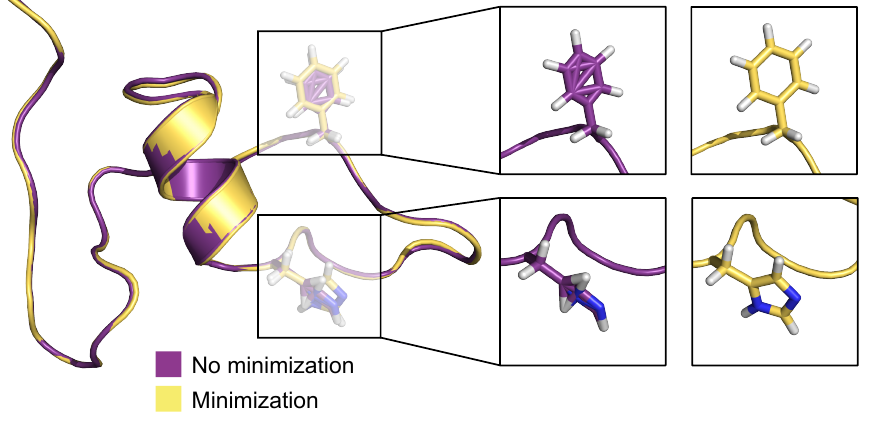
Figure 10. Comparison of pre- and post-minimized structures of the best prediction in the test set, frame